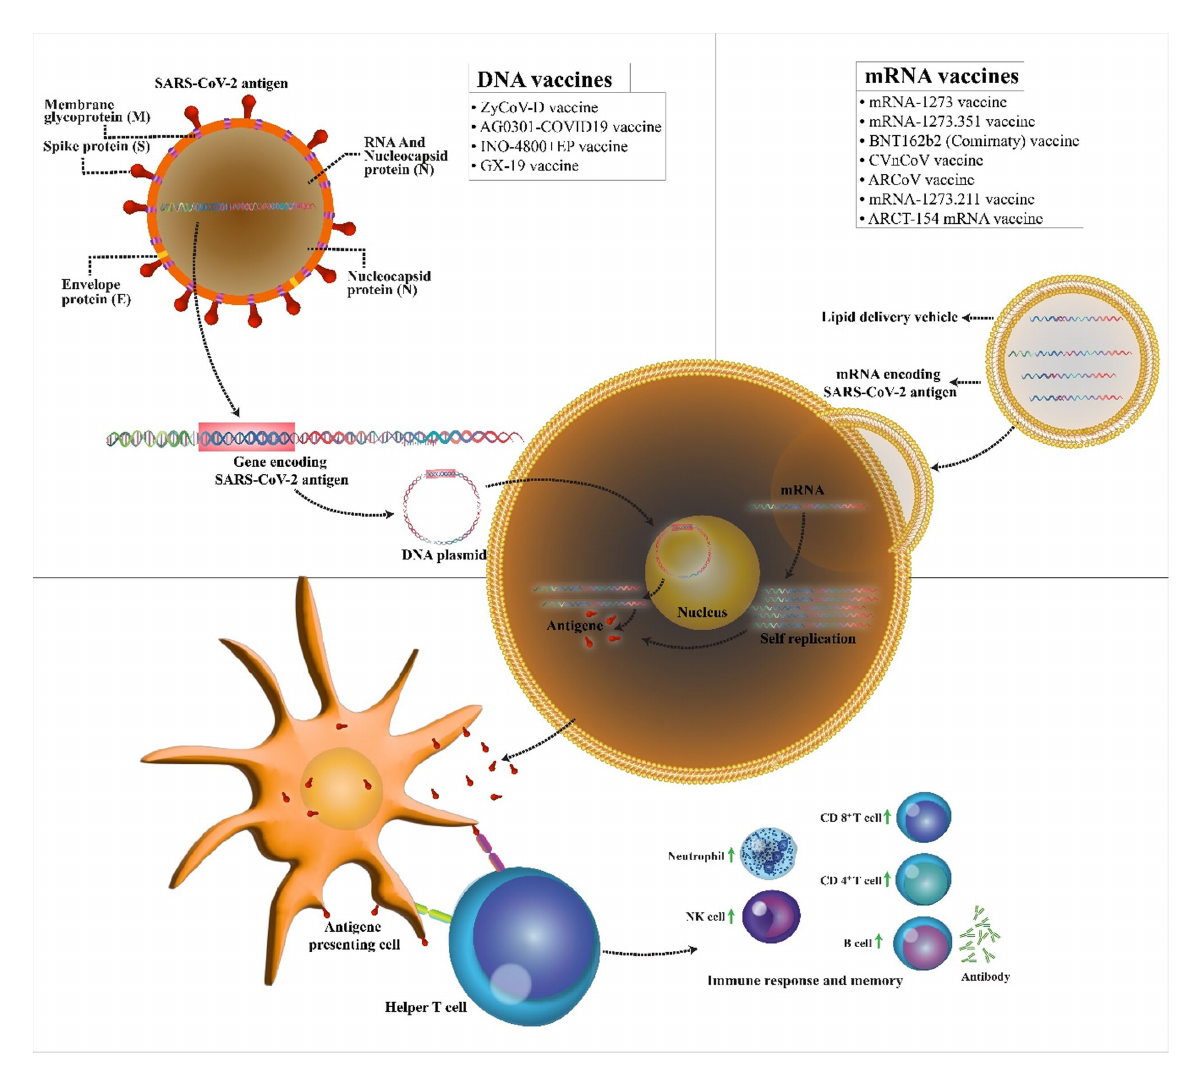
FIGURE 2 Mechanism of action of the COVID-19 DNA and RNA vaccines. COVID-19 mRNA vaccine has strands of messenger RNA inside a coating that protects it from enzymes. COVID-19 DNA vaccine comprises a plasmid that after the vaccine reaches the nucleus, it must be transcripted to an mRNA. In both vaccines, mRNA is translated into the human cells. Next, the encoded protein is expressed in the host cells, and the SARS-CoV-2 antigen can be then presented to antigen-presenting cells. Then, T helper cells stimulate the immune responses including an increase in neutrophils, NK cells, CD 4+ T cells, CD 8+ T cells, and B